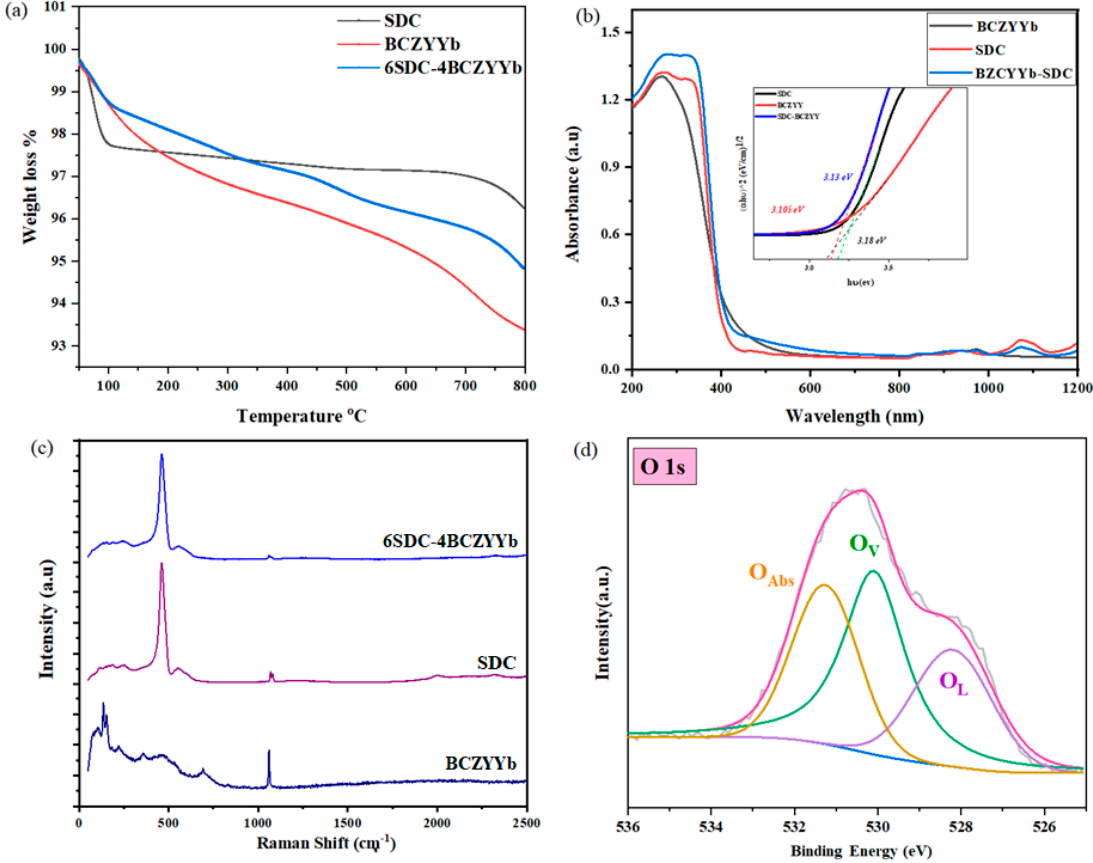
Figure 7. ( a ) Thermogravimetric analysis of SDC, BCZYYb, and BCZYYb-SDC. ( b ) UV-visible absorbance spectra of SDC, BCZYYb, and BCZYYb-SDC. ( c ) Raman spectra of SDC, BCZYYb, and BCZYYb-SDC and ( d ) XPS O1s spectra of